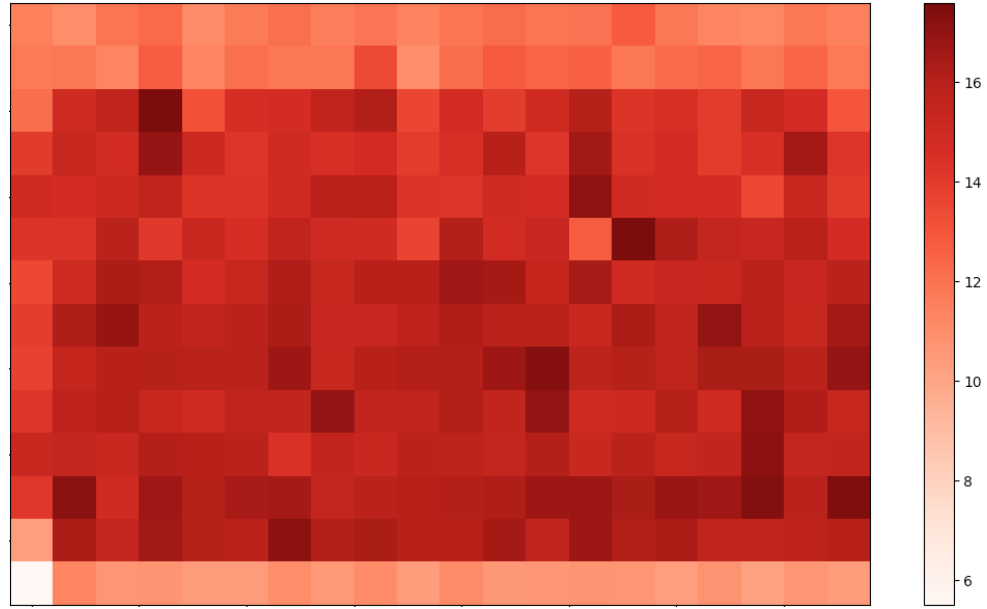
Figure 2. Power measurement matrix of an LED light bulb, measured using the TEST_ORIG profile. Each cell represents the AC power consumed by the load in a single AC period during the measure- ment. The matrix is filled in a row-major way during the measurement. The size of the measurement matrix is determined by r and h